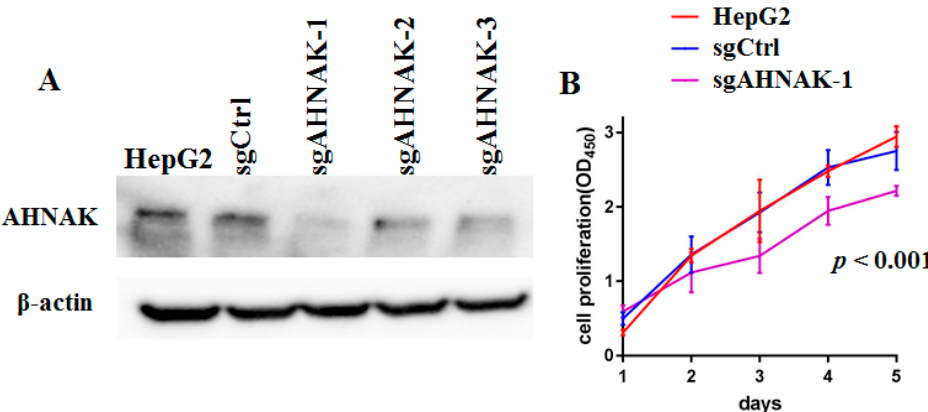
Figure 1. AHNAK expression was essential for HepG2 cell growth: ( A ) Results of Western blotting analysis of AHNAK expression in sgCtrl, sgAHNAK-1, sgAHNAK-2 and sgAHNAK-3 HepG2 cells, and HepG2 cells. ( B ) Cell counting kit-8 assays were used to determine cell viability in sgCtrl and sgAHNAK-1 HepG2 cells, and HepG2 cells (n = 3).